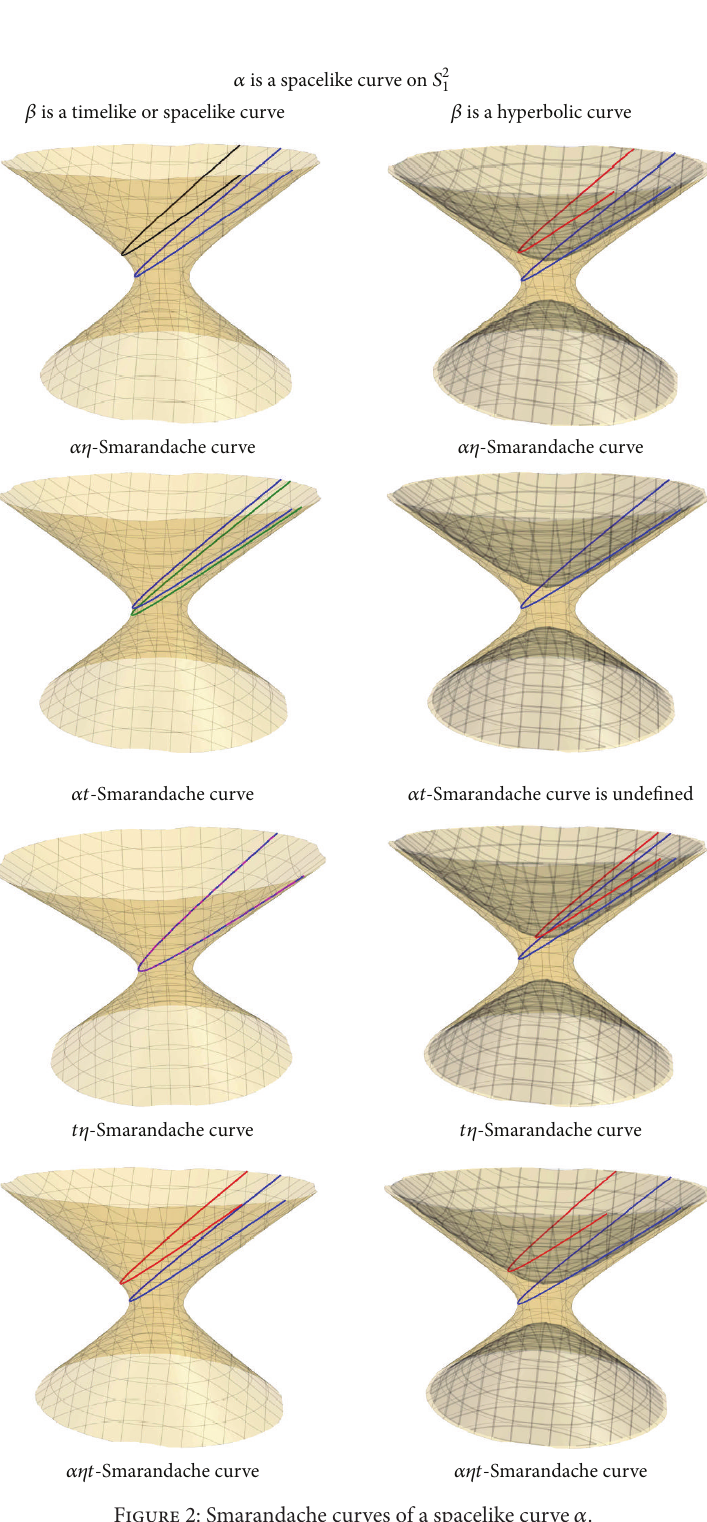
Figure 2: Smarandache curves of a spacelike curve 𝛼